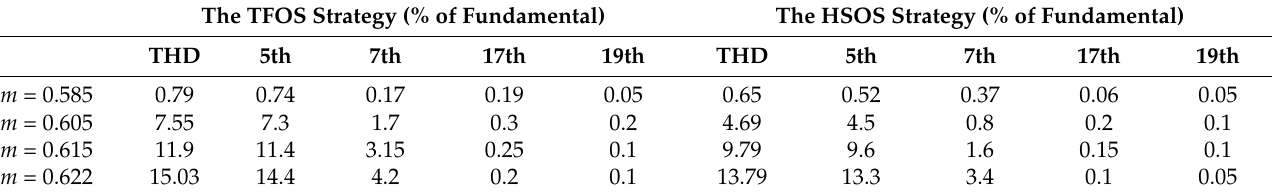
Table 6. Experiment current values of two strategies.